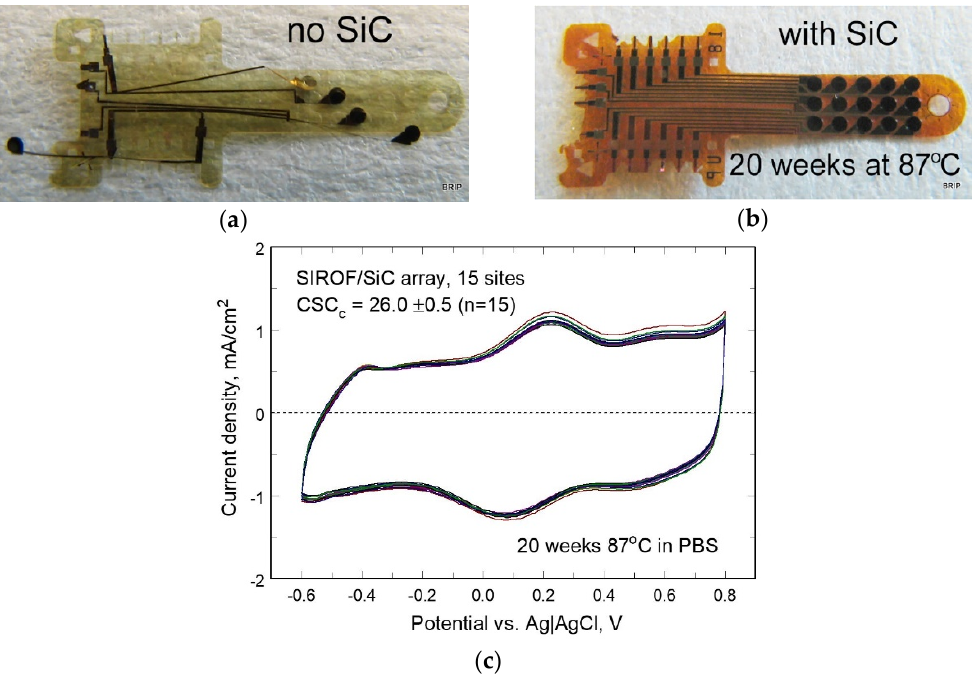
Figure 2. Early micro-fabricated test electrode arrays by the Boston Retinal Implant team. ( a ) The conducting traces interconnecting the contact pads on the left with the 400 µ m diameter Iridium Oxide electrodes on the right were encapsulated in HD Microsystems PI-2611 polyimide only, and quickly de-laminated under accelerated soaking conditions in saline solution at 87 ◦ C; ( b ) multi-electrode arrays which were “wrapped” or encapsulated in 0.5 µ m thick PECVD a-SiC above and below the conductors (in addition to a polyimide outer coating for scratch protection) survived for over 5 months under the same conditions, which we project to be equivalent to over 10 years at 37 ◦ C; similar bio-stability of SiC has been demonstrated elsewhere [28,29]. ( c ) Cyclic voltammetry curves measured from the multi-electrode array of Figure 2b after 20 weeks of saline soaking at 87 ◦ C demonstrated good, consistent charge storage capacity on all 15 sites.